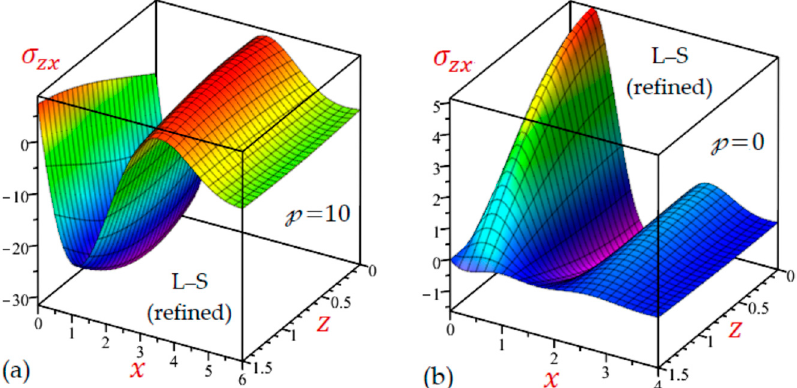
initial pressure ( 𝓅 = 10 ) and ( b ) without initial pressure ( 𝓅 = 0 ) using the refined G–L generalized